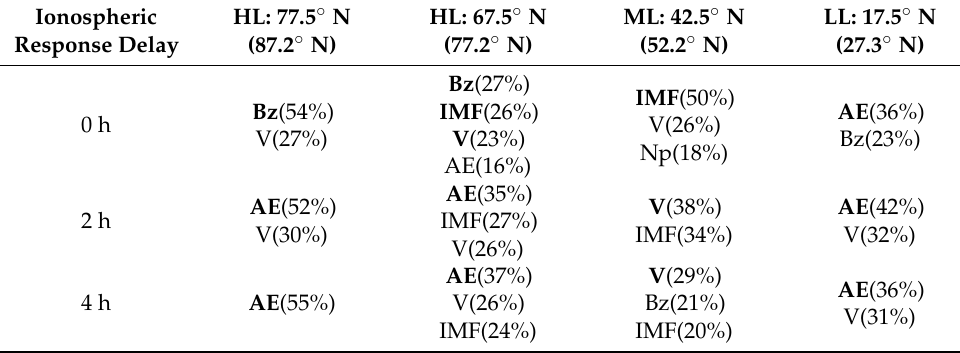
Table 4. The same as in Table 2 but for 21–31 March 2012.